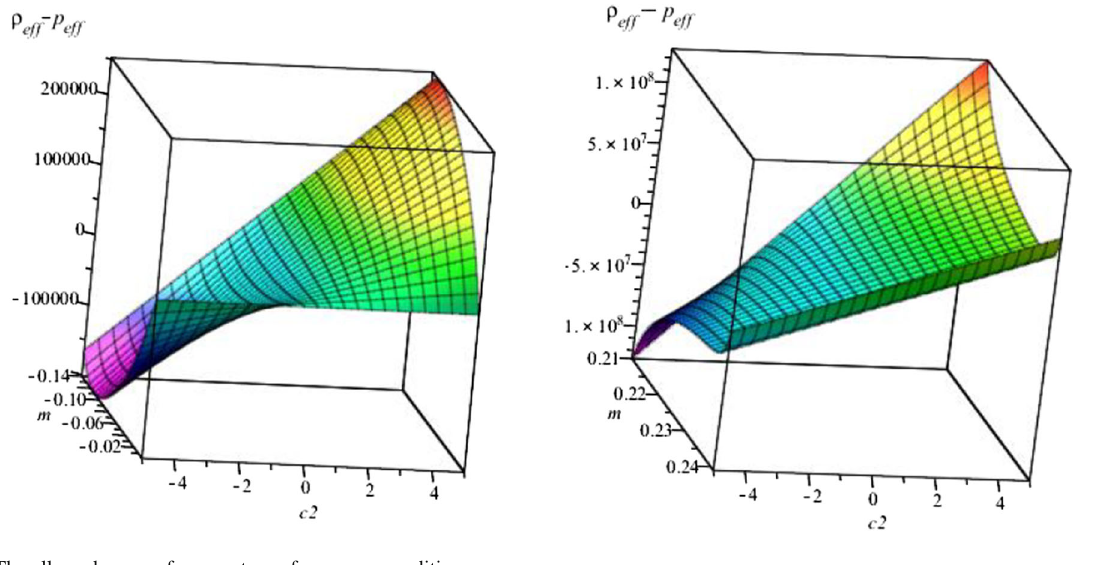
Fig. 3 The allowed range of parameter m for energy